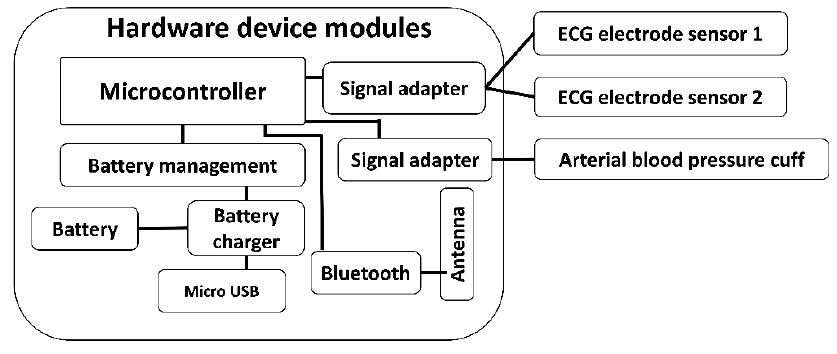
Figure 2. Hardware